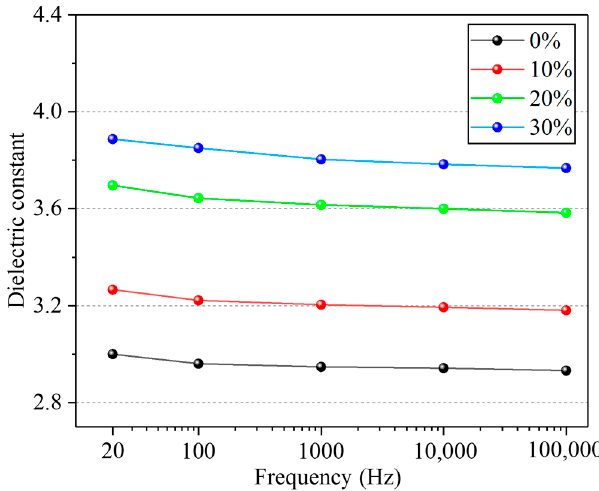
Figure 5. Relative dielectric constant of PDMS composites with BaTiO 3 content of 0%, 10%, 20%, and 30%.